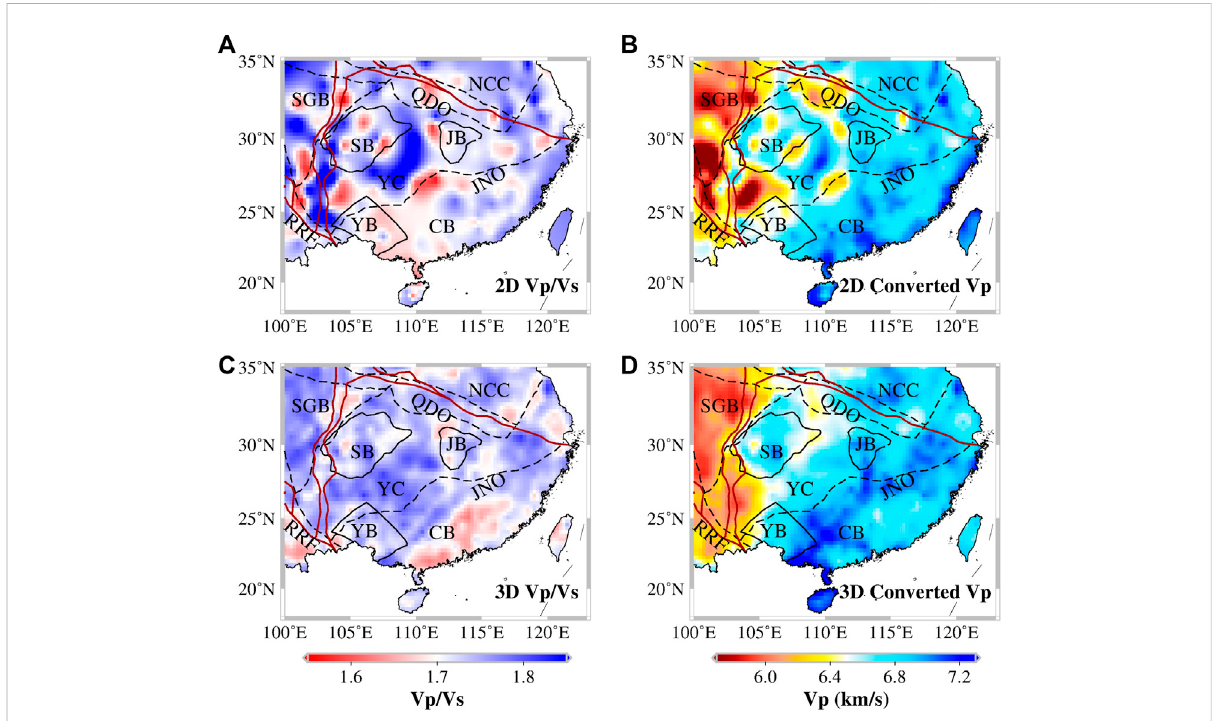
Comparison of the estimated values obtained from the conversion of Vs using the two different approaches. (A) 2D Vp/Vs ratio obtained by receiverfunctionstudy(Heetal.,2014)and (B) theresulting2DconvertedVp. (C) 3DVp/Vsratioobtainedbytomographicstudy(Hanetal.,2021)and (D) the resulting 3D converted